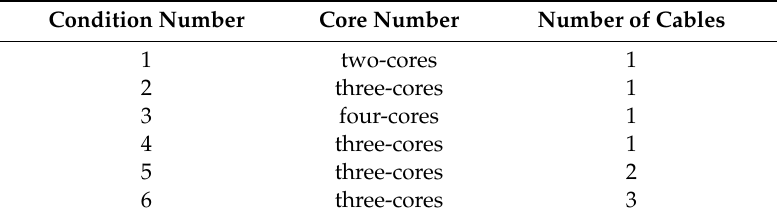
Table 2. Experimental